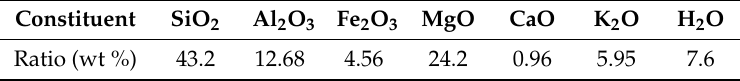
Table 1. Chemical composition of the expanded vermiculite